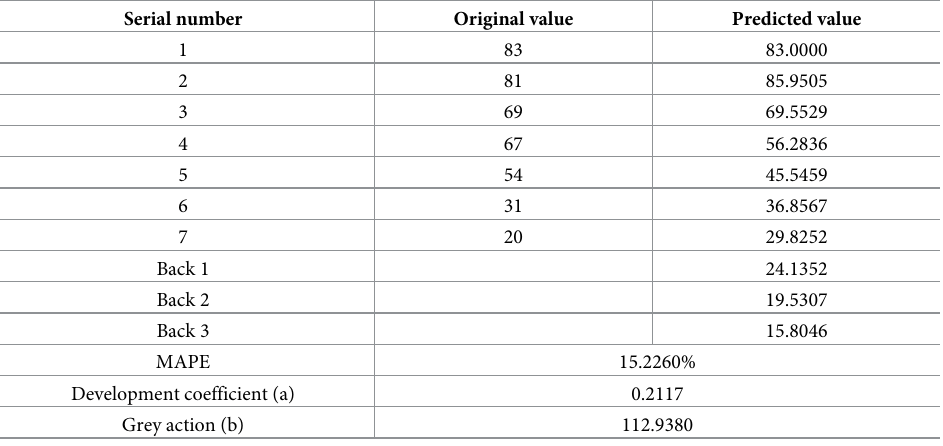
Table 6. Results comparison of traditional GM (1,1)